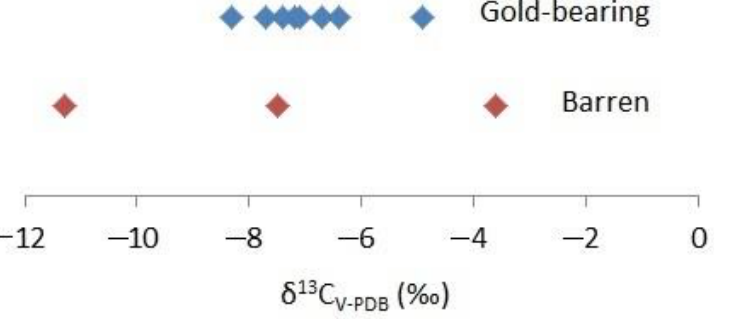
Figure 11. Isotope composition of the carbon ( δ 13 C) of carbon dioxide from fluid inclusions in quartz of the Dobroe deposit: gold-bearing and barren zones.